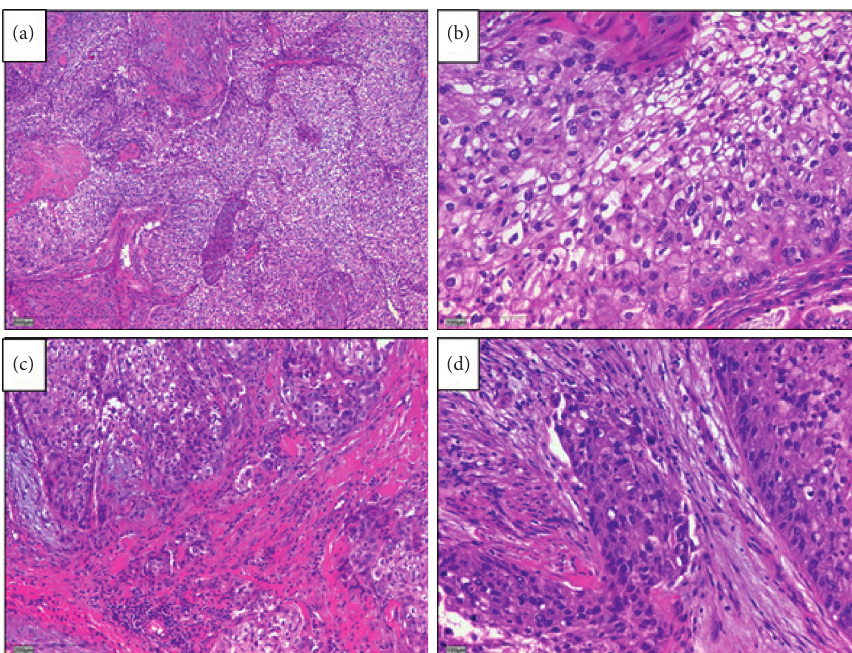
Figure 6: Histopathology revealing parts of the surgical specimen widely occupied by extensions of the temporal bone Schneider papilloma after complete temporal bone resection. Cellular atypia and increased mitoses demonstrate the transition to an invasive, moderately differentiated, nonkeratinizing squamous cell